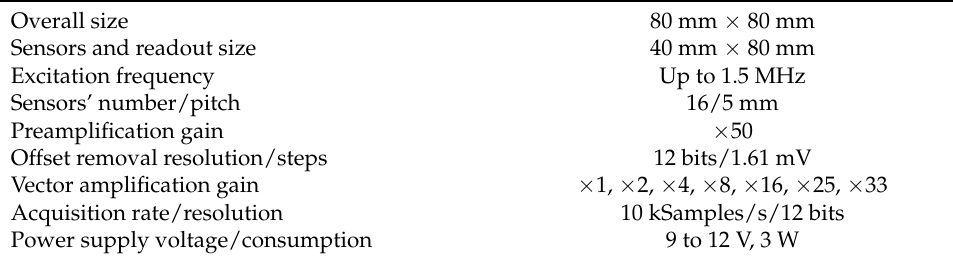
Figure 13. Array probe PCB prototype. Table 2. Array probe-achieved